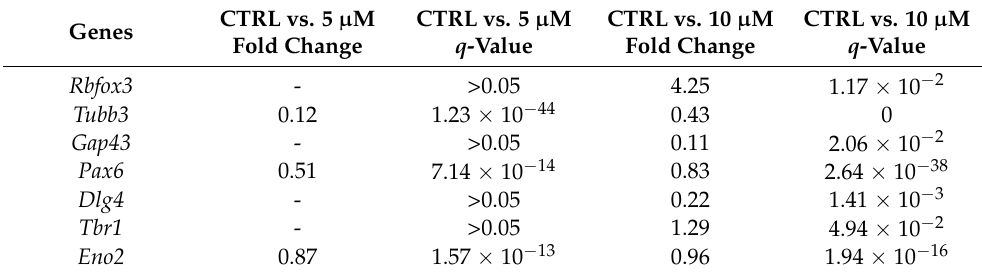
Table 7. DEGs involved in neurodifferentiation.